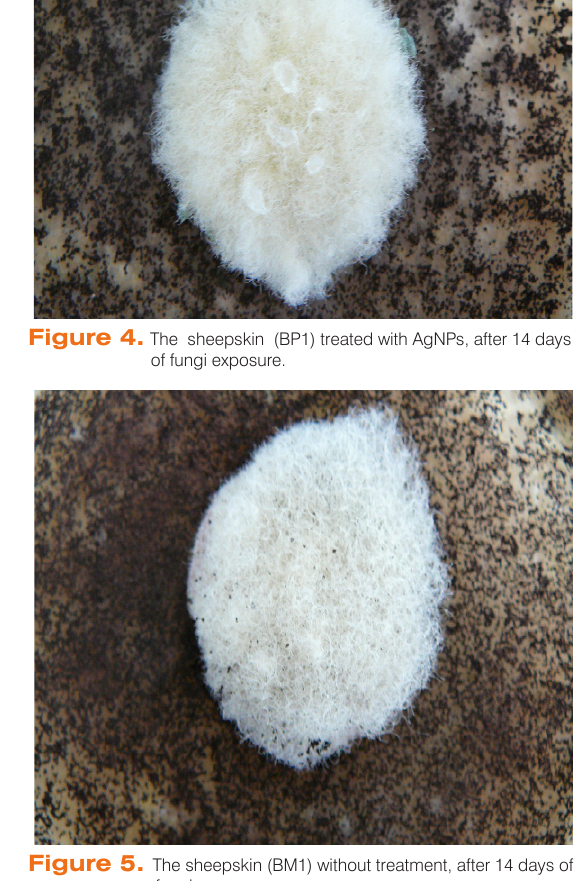
Figure 5. The sheepskin (BM1) without treatment, after 14 days of fungi